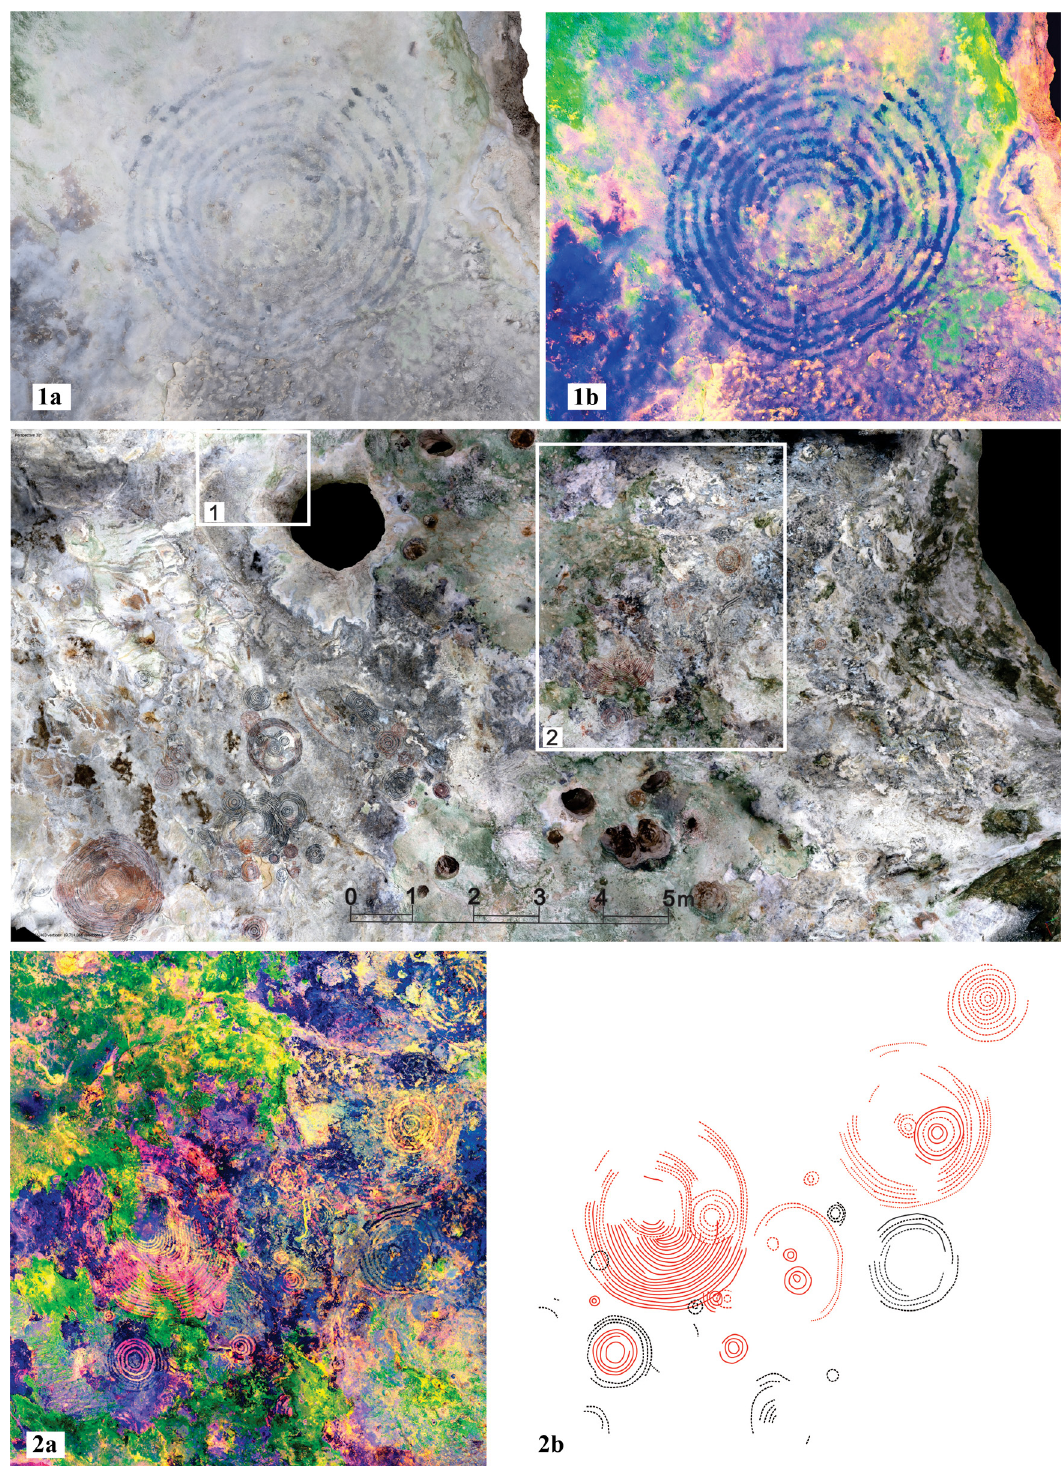
Figure 3: Partial 3D reconstruction of the Cueva No. 1 de Punta del Este, Isla de la Juventud, Cuba. ( a ) The labyrinth pictogram. ( b ) Visualization of pictograms using Dstretch and digital